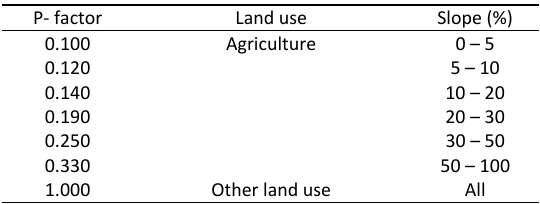
Table 2: Assigned P-factor value for different land use and slopes